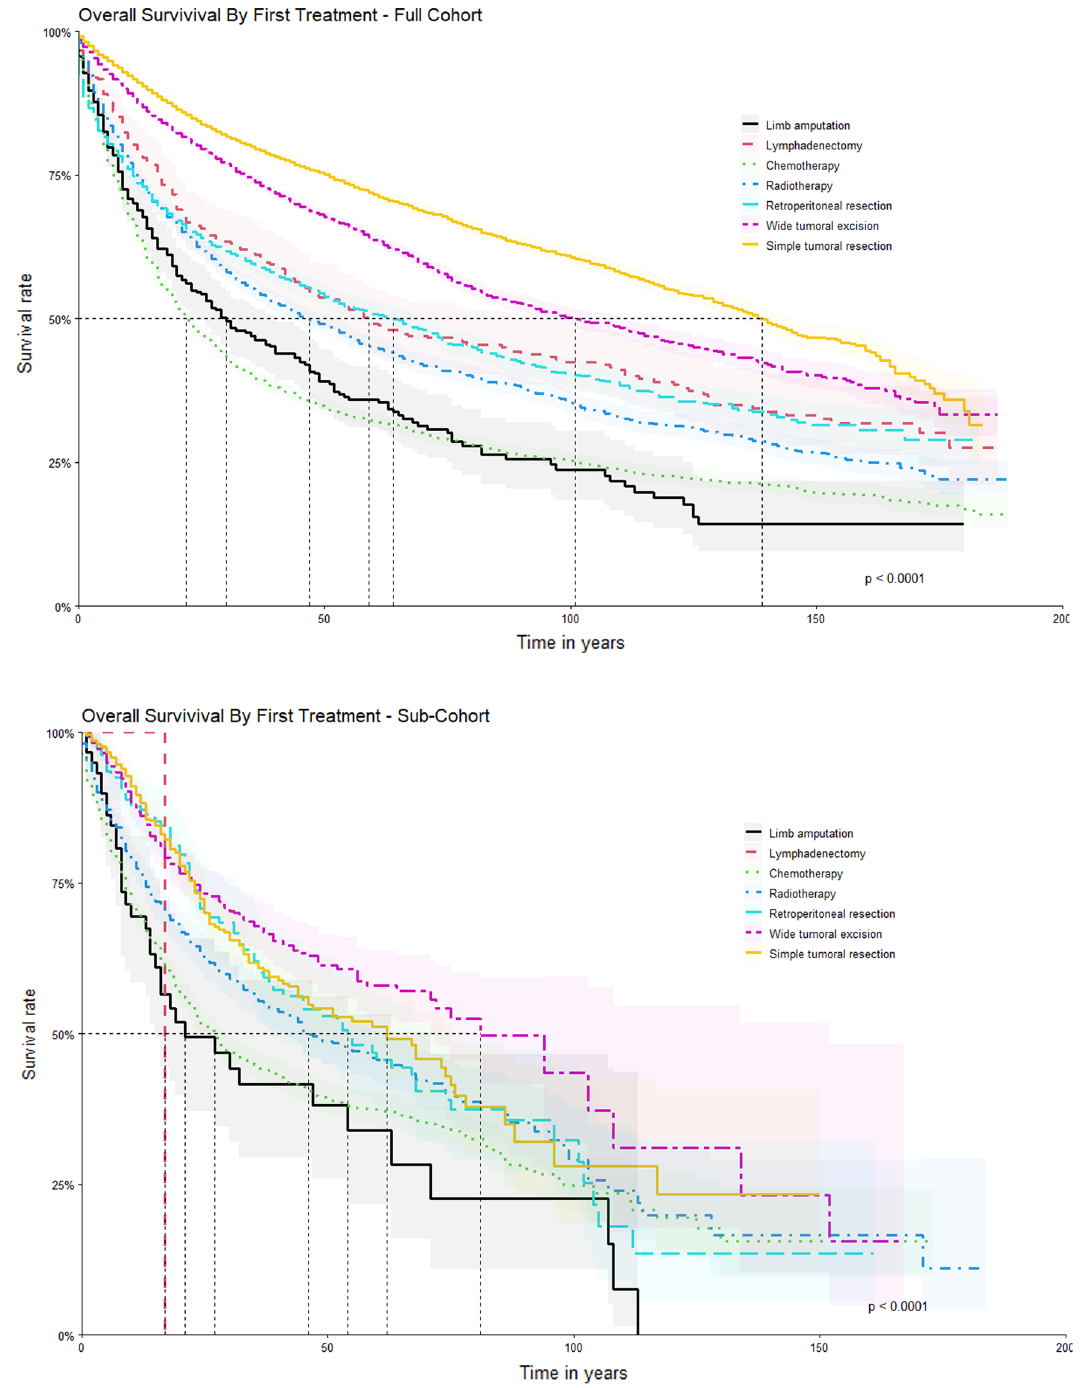
Figure 3. Compared Survival by Type of First Treatment between Full Cohort and Only Staged Patients (Above: Full cohort with 66,852 patients. Below: Sub-cohort with 4980 staged